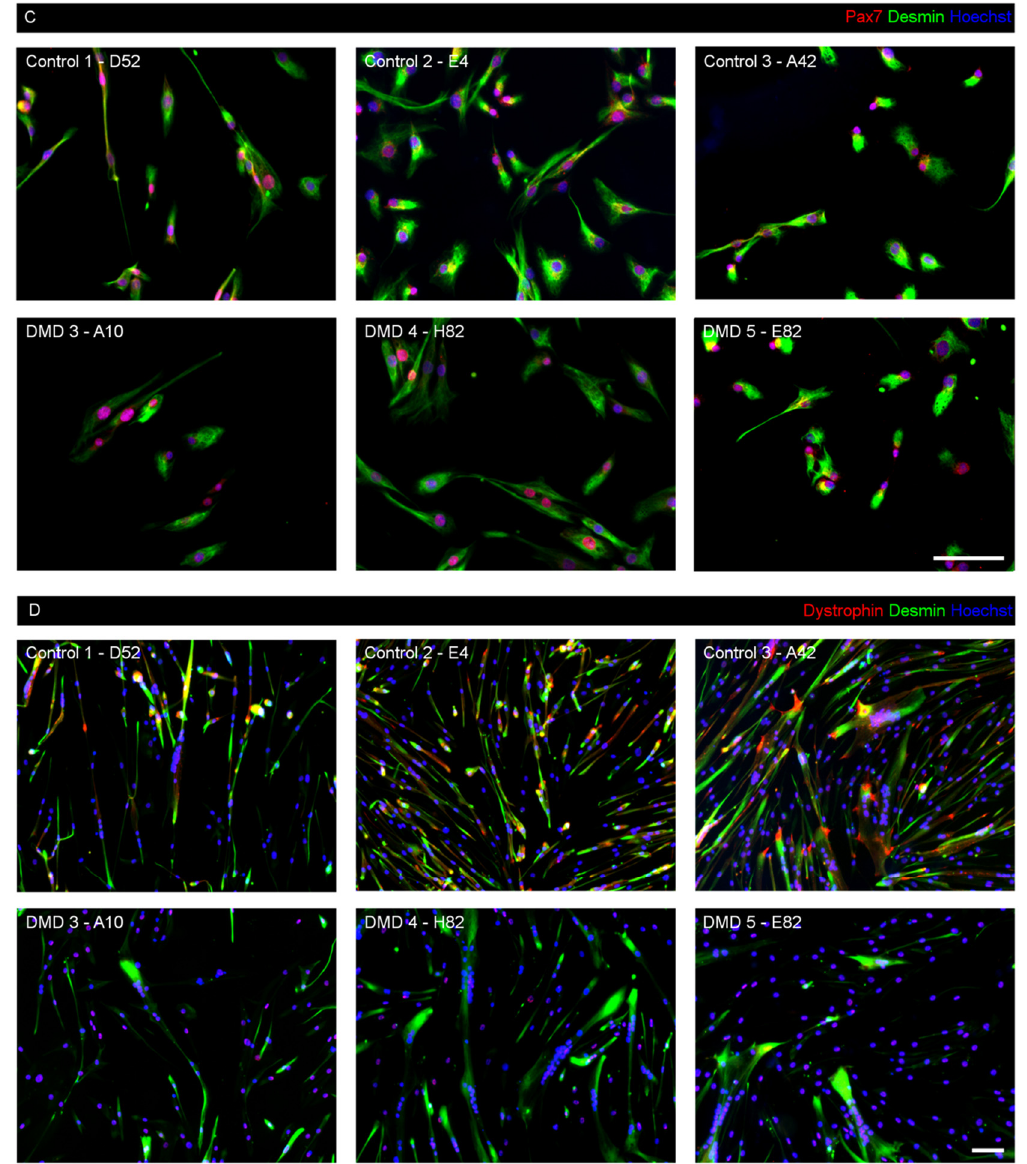
Figure 2. Myogenic nature of iHMuSC clones. ( A , B ) Primary HMuSCs and iHMuSC clones were tested for CDK4 ( A ) and TERT ( B ) gene expression using RT-qPCR. ( C ) Immunostaining for the myogenic markers Pax7 (Red) and desmin (green) in growing iHMuSC clones. ( D ) Immunostaining desmin (green) and dystrophin (red) in differentiated iHMuSC clones. Nuclei are labelled with Hoechst (blue). Bars = 100 µm.